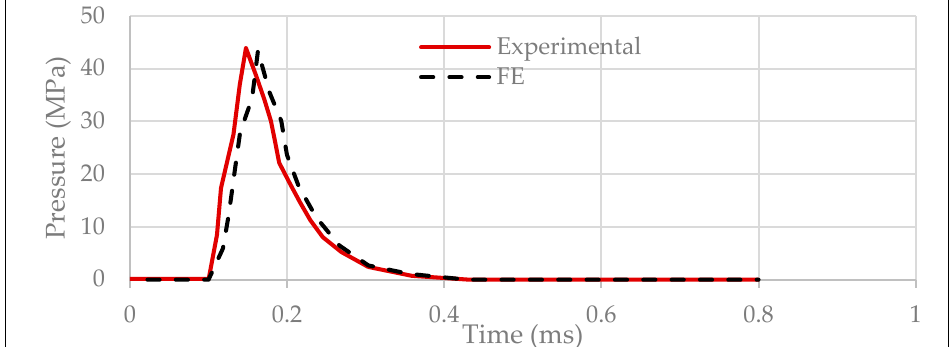
Figure 8. Pressure–time diagram obtained in the present study for validation process.